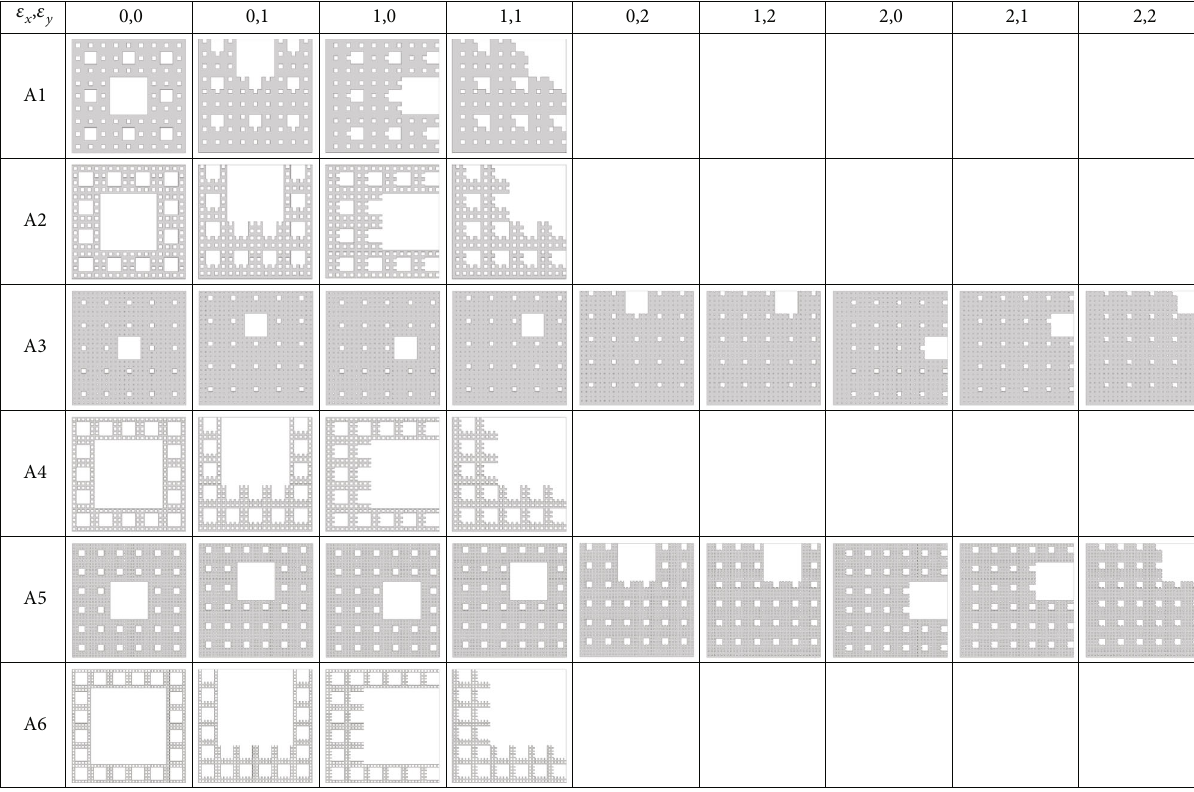
Figure 2: The 3rd order of the isotropic and anisotropic Sierpinski carpet